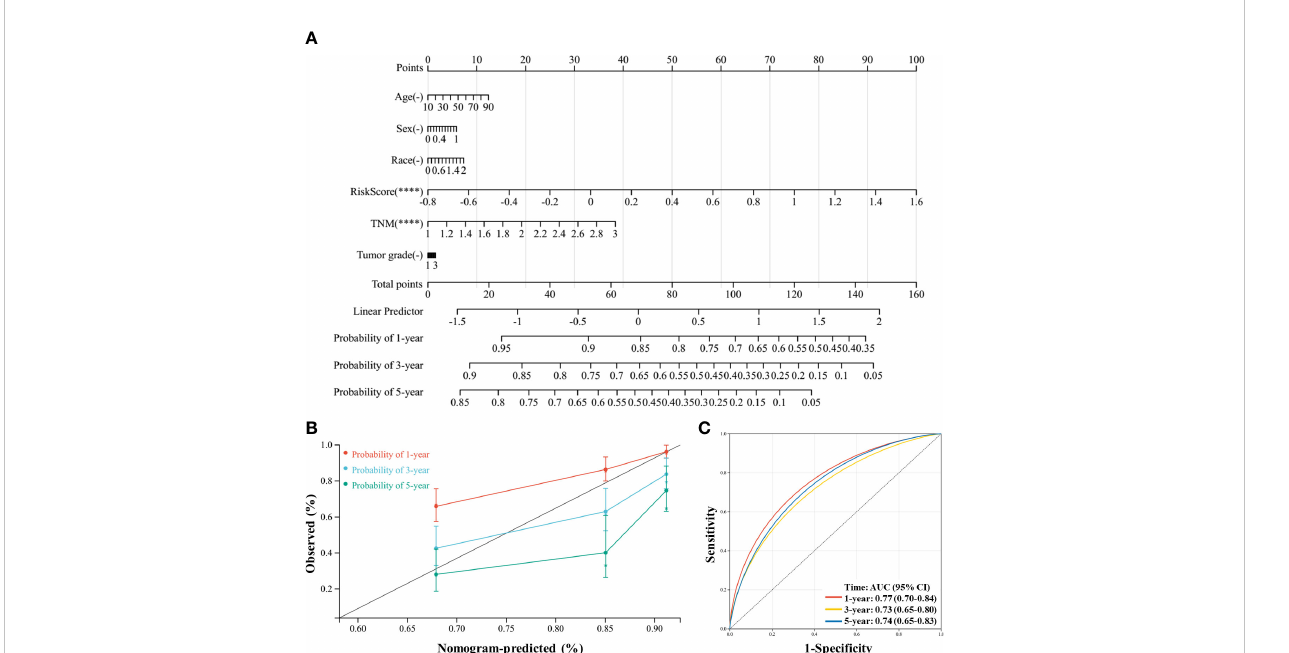
FIGURE 9 A nomogram was constructed to predict the probability of the 1-year, 3-year, and 5-year overall survival (OS) in patients with hepatocellular carcinoma (HCC). (A) The nomogram was constructed based on six factors, and the results suggest that the risk score and TNM (tumor, nodes, metastases) stage signi fi cantly affected the OS of patients with HCC. For the factor sex, 0 represents male and 1 represents female; for the factor race, 0 represents white, 1 represents Asian, and 2 represents others; for TNM, 1 represents stage I, 2 represents stage II, and 3 represents stages III and IV. (B) Calibration plots of the nomogram for the 1-year, 3-year, and 5-year OS. (C) , Receiver operating characteristic (ROC) curve of the nomogram prediction model. **** P <